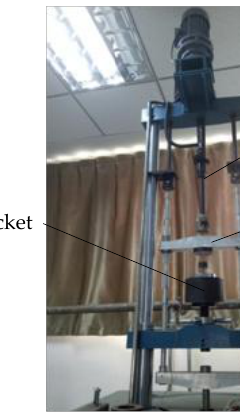
Figure 5. A photo of the force-testing machine.